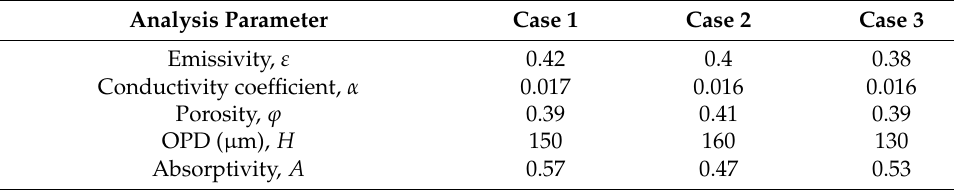
Table 5. Analysis parameter case for